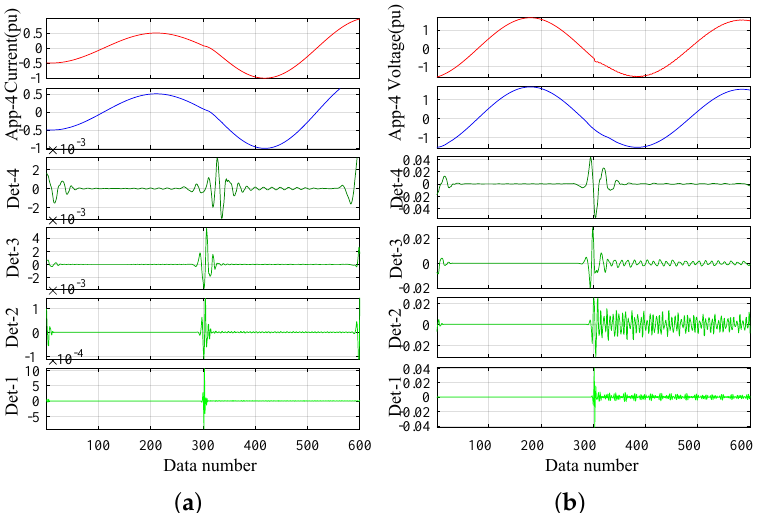
Figure 6. Wavelet transform coefficients of Phase-a ( a ) current and ( b ) voltage signal during the a-g fault for grid-connected radial mode operation at Lines